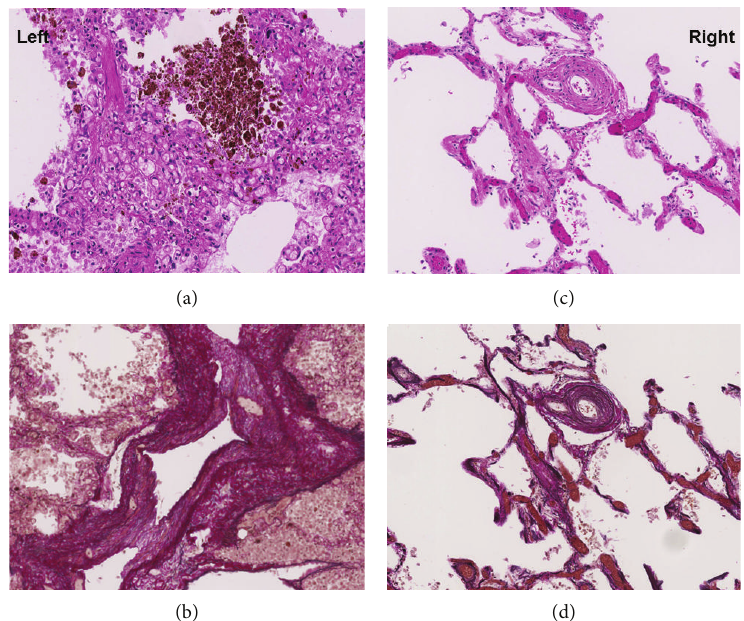
Figure 2: Histological pictures from the left lung (a) showing thickening of the alveolar septa due to capillary proliferation and congestion. In addition, massive iron deposition in the alveolar spaces secondary to venous obstruction is found. The Elastic van Gieson (EvG) staining (b) highlights arterialization and intimal fibrosis of venules in the interlobular septa with subtotal luminal occlusion. In contrast to the left lung, the right lung is characterized by a normal alveolar architecture with only minimal congestion (c). The EvG staining (d) shows intimal proliferation and media hyperplasia possibly related to pressure overload of the right lung but no signs of PCH or PVOD.